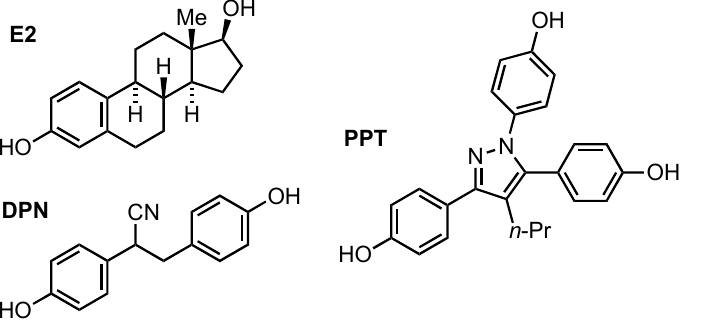
Figure 1. Structures of 17 β -estradiol ( E2 ), ER α -selective agonist 1,3,5-tris(4-hydroxyphenyl)-4-propyl- 1 H -pyrazole ( PPT ), and ER β -selective agonist 2,3-bis(4-hydroxyphenyl)propionitrile ( DPN ). Numerous non-steroidal molecules are known [4,5] to bind to ER α and/or ER β , in- cluding the ER α -selective agonist PPT [6] and the ER β -selective agonist DPN [7] (Figure